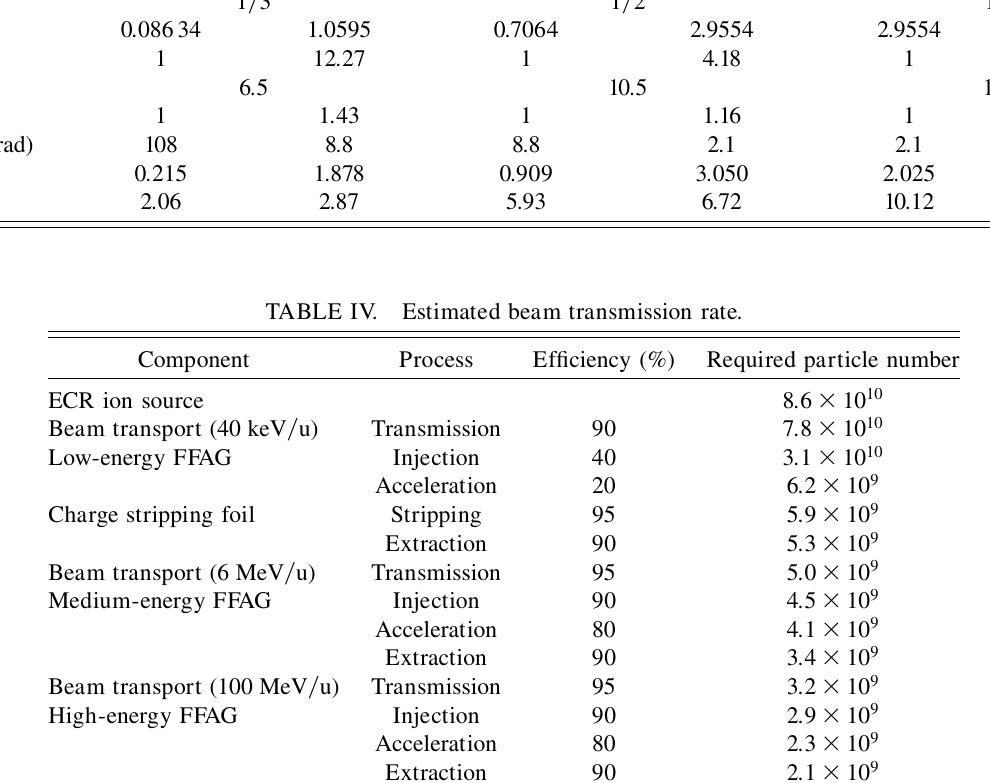
(cid:7) k (cid:1) 1 , B=B 0